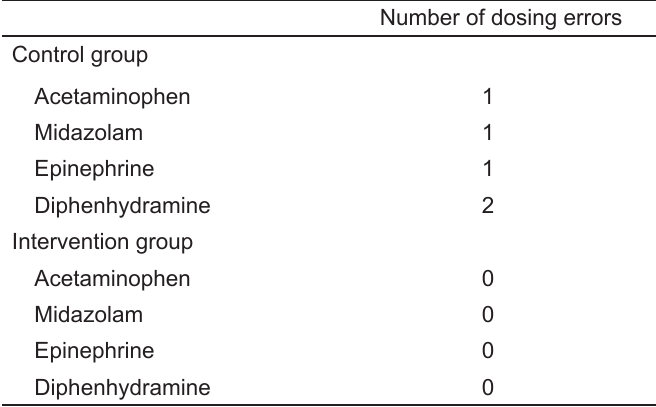
Table 3a. Dose error in each group.